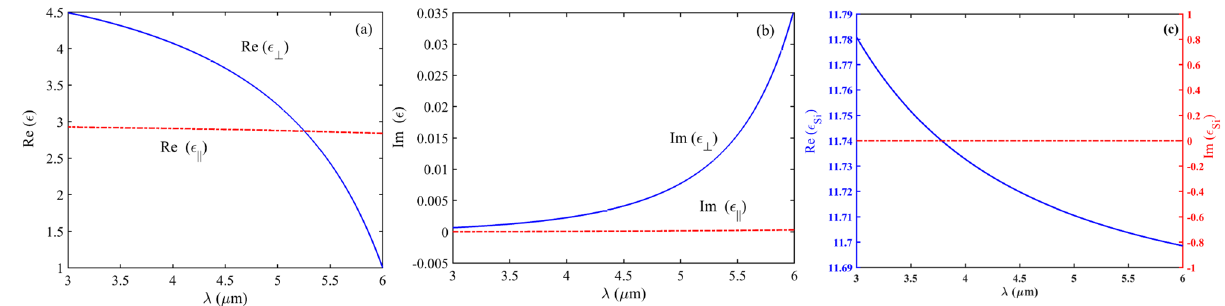
Figure 3. The real ( a ) and imaginary ( b ) parts of hBN anisotropic permittivity ( c ) The Real and imaginary parts of Si permittivity as a function of wavelength,